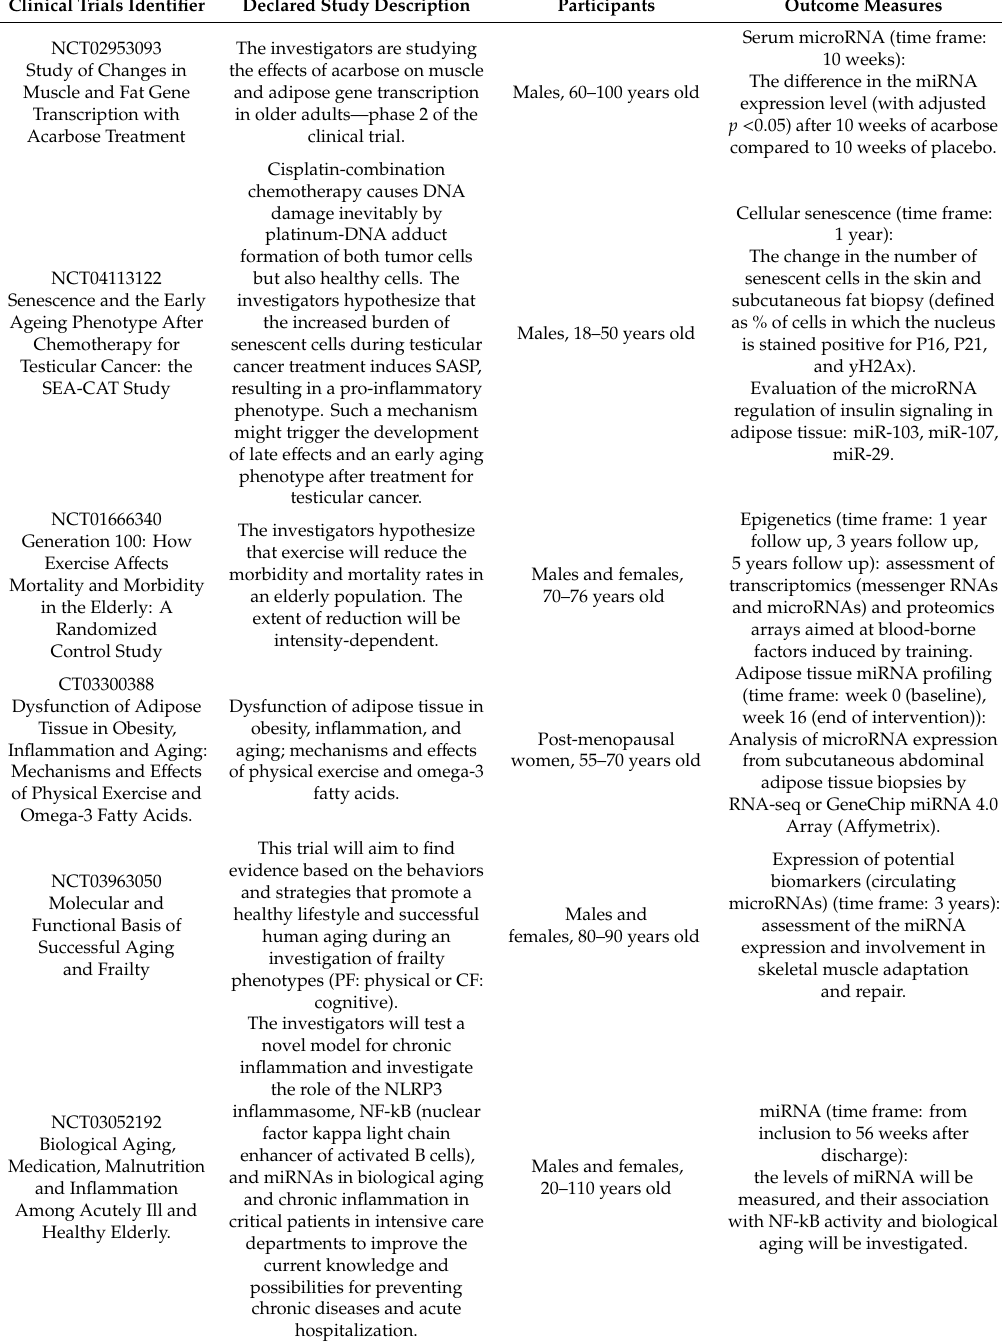
Table 4. Ongoing clinical trials associated with aging and age-related conditions which use miRNAs as a target or a